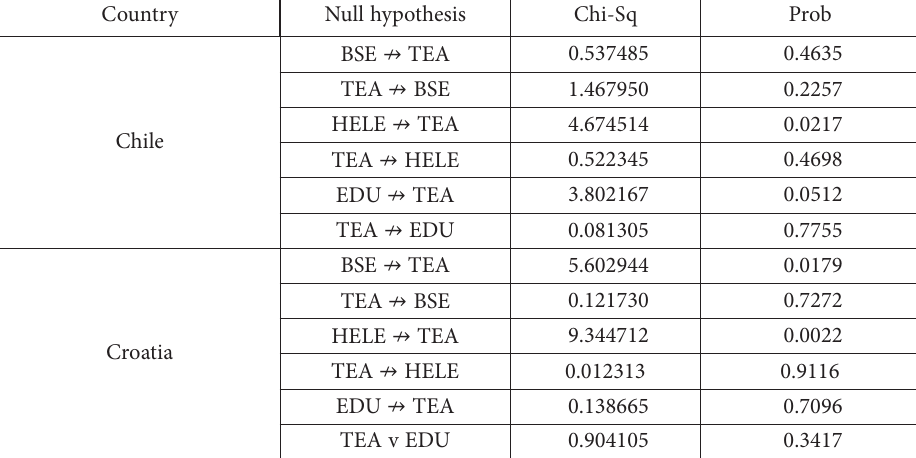
Table 10. Toda and Yamamoto (1995) causality test results